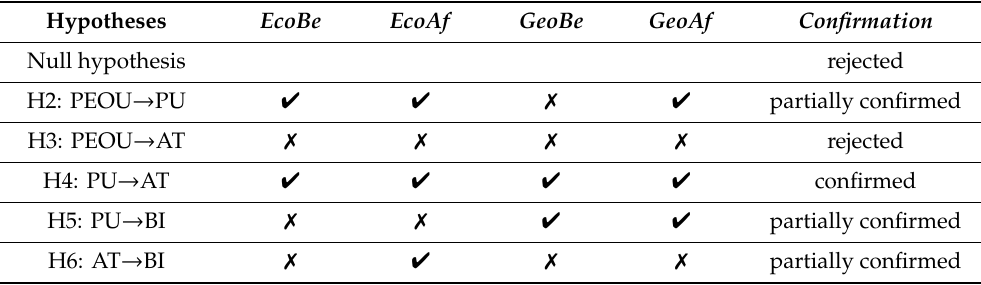
Table 7. Confirmation of